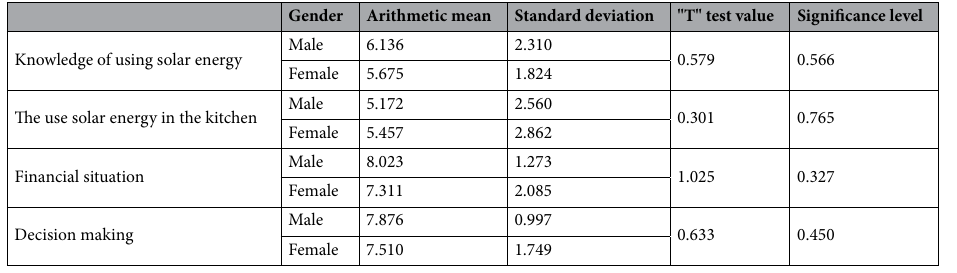
Table 5. Results significance level for